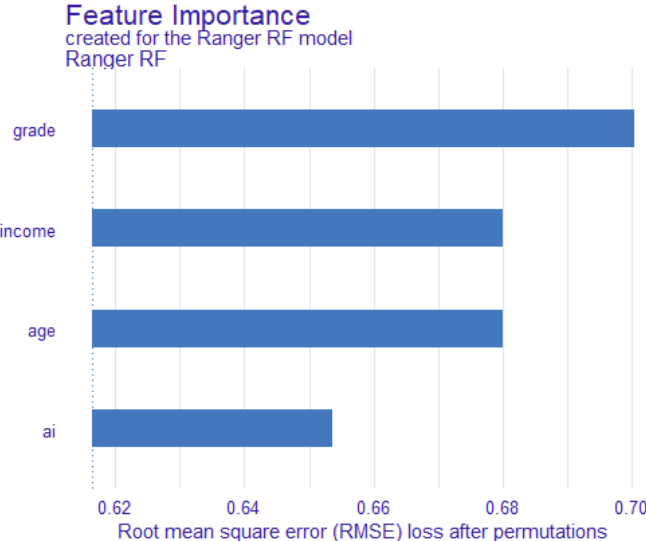
Figure 1. Importance ranking of variables on social adaptability predicted by RF. Table 2. Social adaptability differences between AI group and non-AI group.